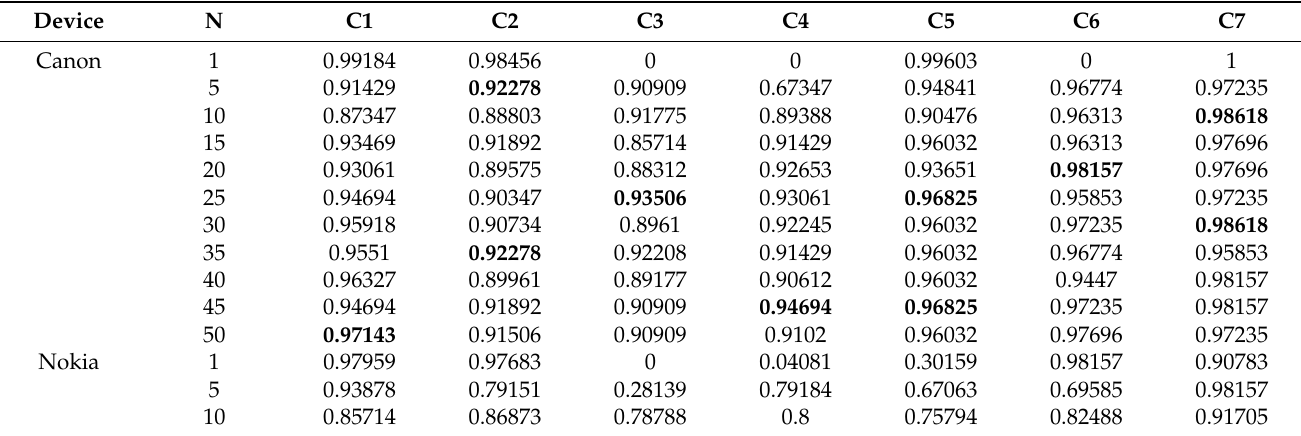
Table 5. Battery of experiments to compute the hue